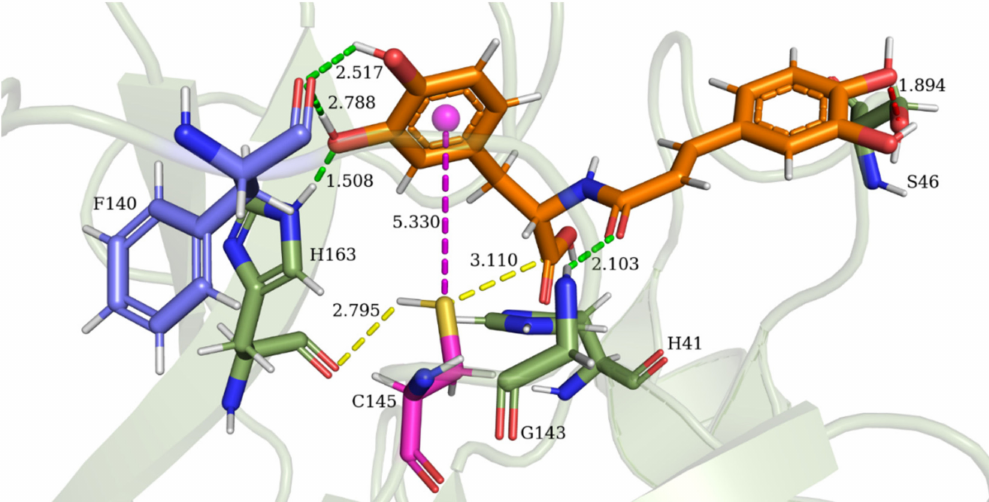
Figure 2. In situ ligand minimalized structure of the docking pose of clovamide to M pro . S(C145) points to the catechol ring evolved to a longer distance of 5.330 Å (magenta dash line). In our proposed mechanism, H(C145) was first deprotonated by backbone O(H163) (2.795 Å), followed by a thiolate ion attack to the carboxylic acid group (3.110 Å), forming a thioester covalent linkage. Green dash lines represent hydrogen bonds providing non-covalent stabilizations towards the complex. The red dash line at right shows a minor unfavorable hydrogen bond donor–donor interaction between O(catechol) and O(S46)